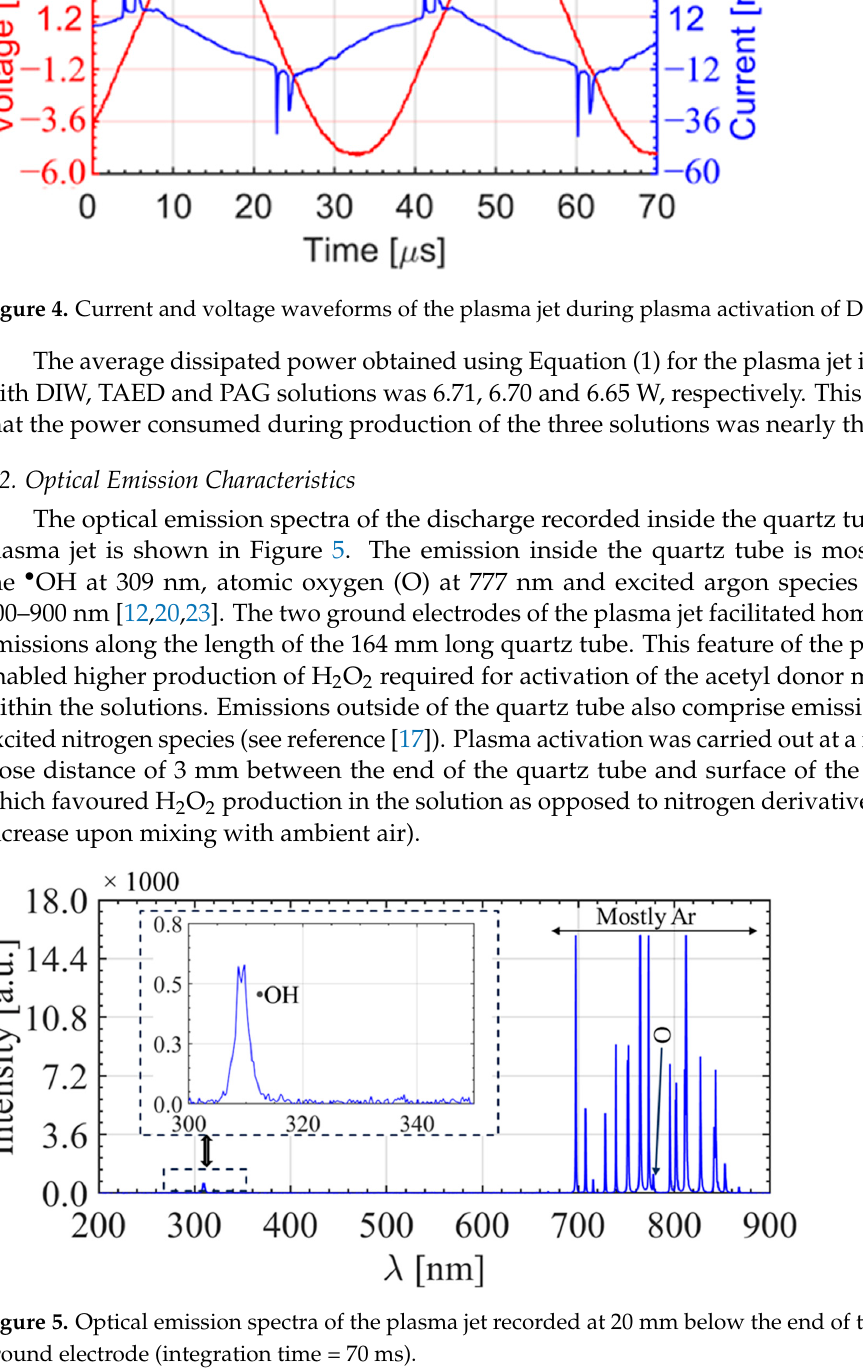
Figure 5. Optical emission spectra of the plasma jet recorded at 20 mm below the end of the second ground electrode (integration time = 70 ms). 3.3. Chemical Analysis of the Plasma Activated Solutions Previously, it has been shown that the total concentration of RONS in PAW correlates with its absorbance profile measured by ultraviolet-visible (UV-vis) spectroscopy [24]. Therefore, as a first initial assessment, the UV-vis profile of the plasma activated solutions was measured. Figure 6 shows the UV-vis absorbance of PA-DIW, PA-TAED and PA- PAG across a wavelength range of 200–350 nm. Considering the area under the curves, it